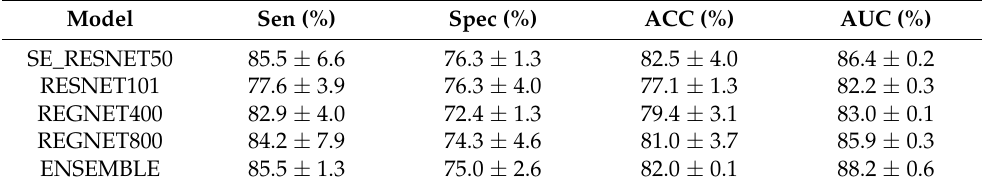
Table 2. Results of different network models and ensemble models in the validation